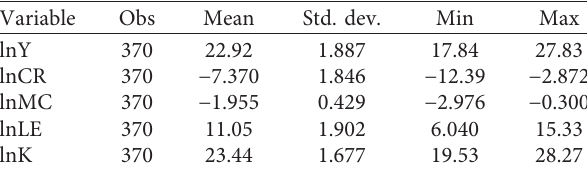
Table 1: Statistical description of